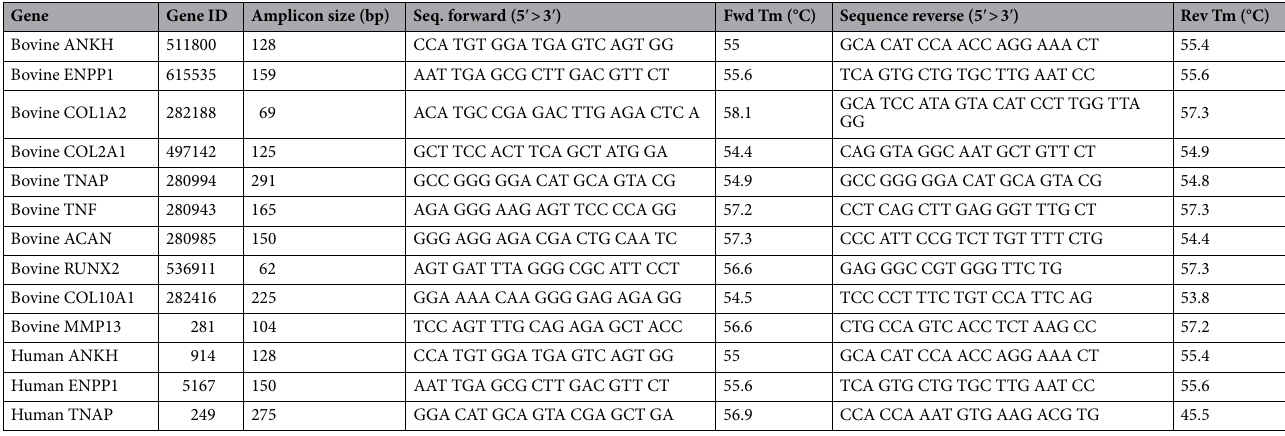
Table 2. List of